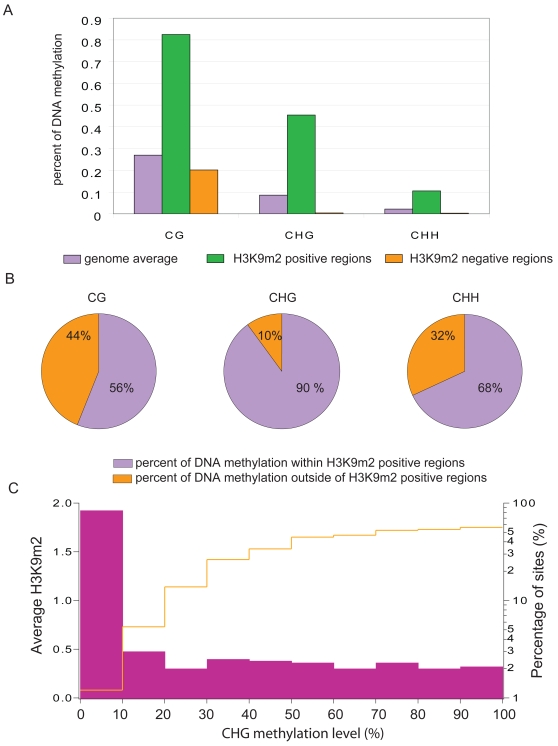
Correlation of H3K9m2 methylation with CHG DNA methylation.(a) Average DNA methylation levels genome wide (purple), in H3K9m2 positive regions (Z score>1, green) and in H3K9m2 negative regions (Z-score<0, orange). (b) Percent of CG, CHG and CHH methylation falling within H3K9m2 positive regions. (c) Correlation of the percentage of CHG methylation at individual sites throughout the genome with H3K9m2 levels. The x-axis is divided onto 10 individual bins that represent deciles of the percentage of CHG methylation of all CHG sites in the genome. Purple bars represent the percentage of CHG sites that fall with each methylation decile (right logarithmic axis), and orange line represents the average H3K9m2 level (Z-score) (left axis).